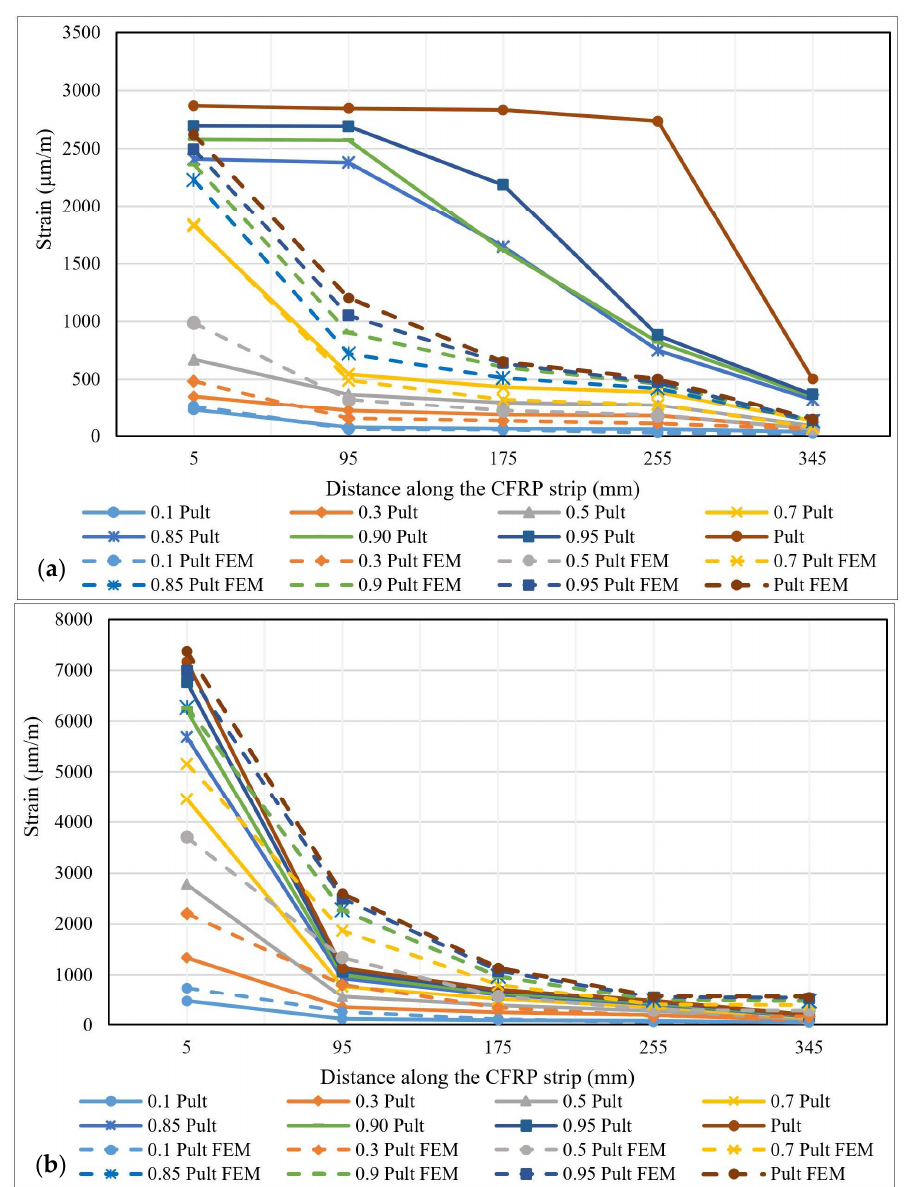
Figure 23. Strain distributions along the contact area between the CFRP strips and the steel plates for specimens: ( a ) S-M514-30-2 and ( b ) S-S512-330-1.